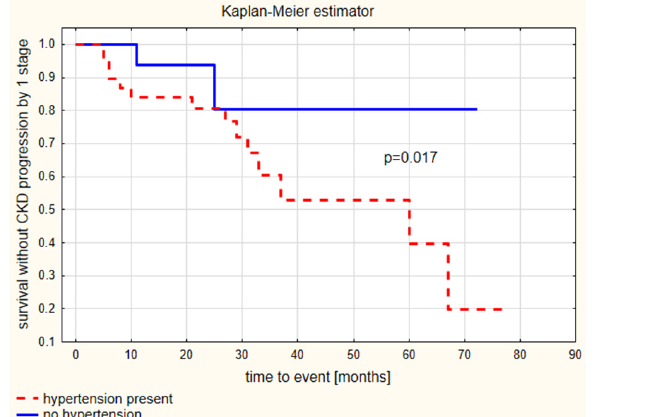
Table 4. Diagnostic accuracy of predicting annualized eGFR slope ≥ 3 mL/min/1.73 m 2 /year. SBP and DBP dipping acting as destimulants and DBPr and MAPr acting as stimulants.